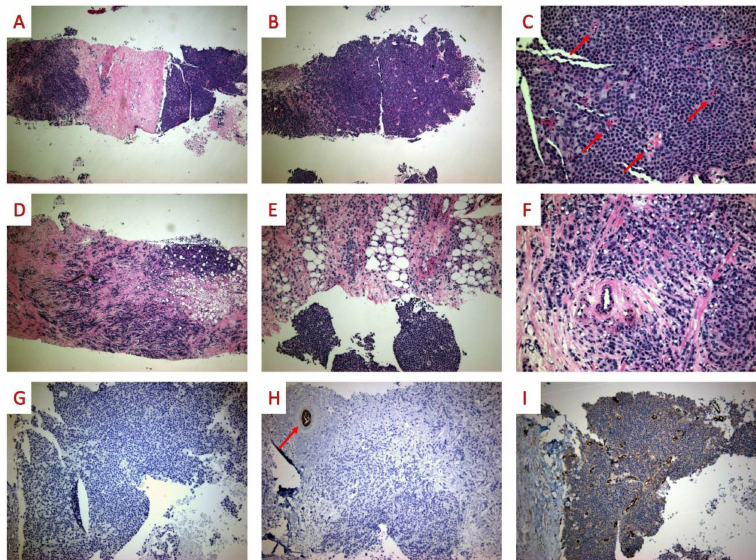
Figure 2. ILC with papillary features. (( A , B ) 40 × ): The tumor consists of two components. The first had a solid architectural pattern. (( C ) 200 × ): On high power examination, fibrovascular cores (red arrows) were observed. (( D , E ) 40 × ): The second component shows a typical classic variant ILC morphology, with a single-file pattern and single-cell infiltration. (( F ) 200 × ) On high-power examination, several signet-ring cells were visible. (( G , H ) E-cadherin 100 × ): Immunohistochemically, E-cadherin was negative in both tumor components. Normal ducts and lobules served as an internal control (red arrow). (( I ) β -catenin 100 × ): β -catenin was negative as well.